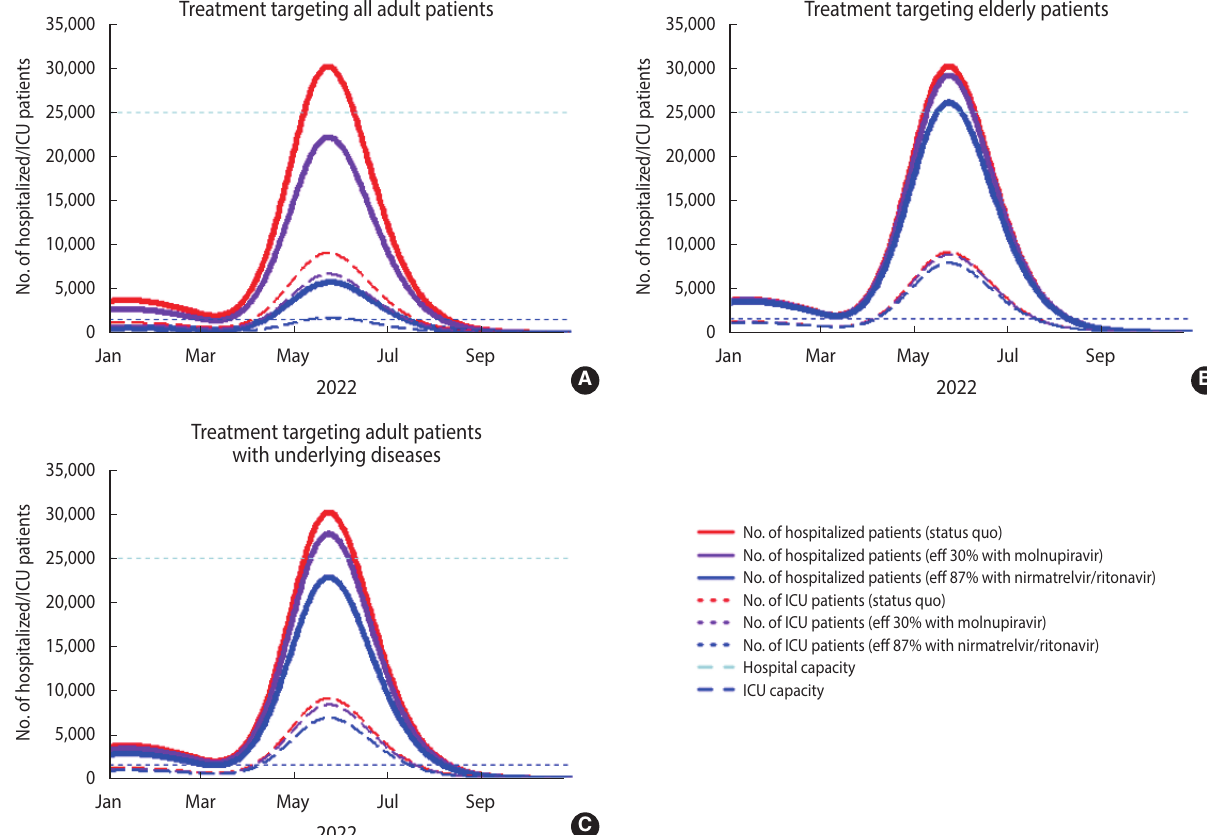
Figure 1. Number of hospitalized COVID-19 infected patients for each treatment scenario (standard care, molnupiravir, and nirmatrelvir/ ritonavir). Treatment targeting all adult patients (A) elderly patients (B), and adults patients with underlying diseases (C). eff, efficacy; ICU, intensive care